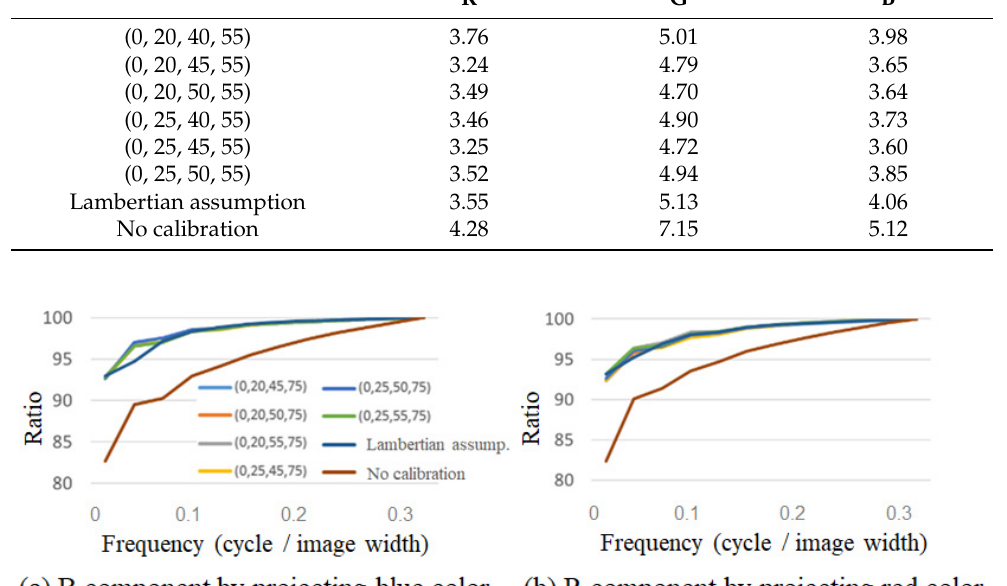
Figure 10. Comparison of cold and warm colors (green projection onto open lens type).